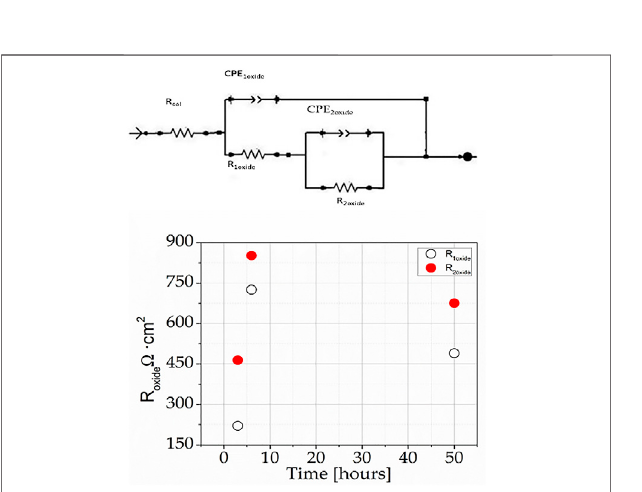
FIGURE 9 | R 1oxide and R 2oxide variation for 3, 6, and 50 h in the salt solution.